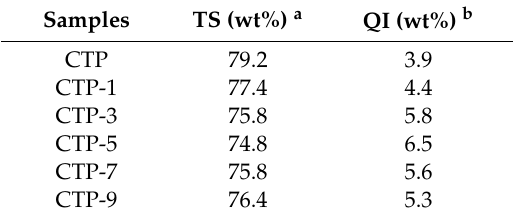
Table 1. Solubility class separation of the CTP and modified CTP by sequential Soxhlet